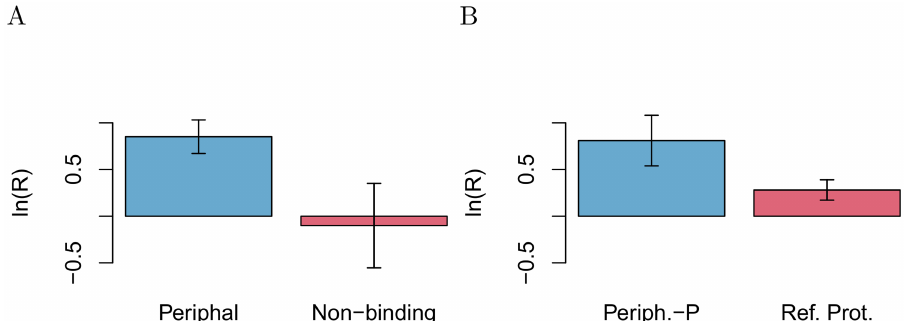
Fig 4. The ‘protruding hydrophobes’ tend to be ‘co-insertable’ in peripheral proteins. Panel A shows the comparison between the data sets ‘Peripheral’ and ‘Non-binding surfaces’, and B the comparison between the ‘Peripheral-P’ and ‘Reference Proteins’. The tendency for protrusions to be co-insertable is quantified by the weighted frequency of co-insertion (Eq 9), and is compared between each data set and a null model using the odds ratio (Eq 10). Positive values reflect higher frequencies of co-insertion than in the null model. More precisely we plot Þ where set represents the set of peripheral proteins (blue) and the corresponding reference set (red), R ð set ; null ; ^ F pair one ; both and null represent their respective null models where hydrophobes have been relocated randomly among protrusions as described in ‘Materials and methods’. Error bars are 95% confidence intervals.